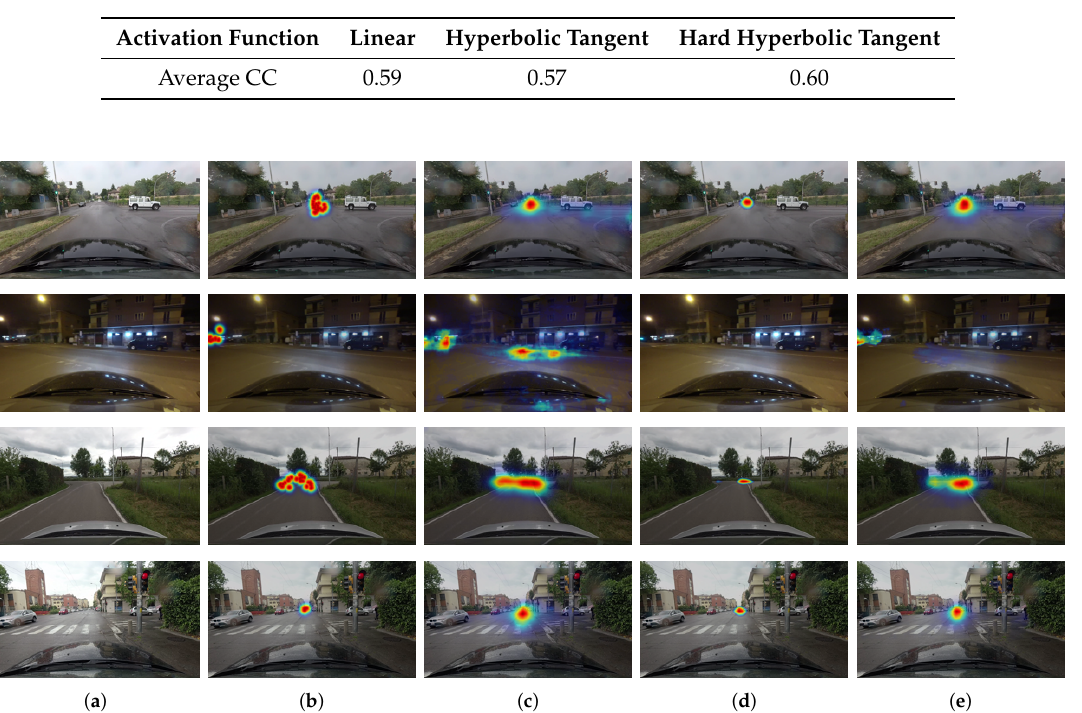
Table 2. Analysis of attention performance with different activation functions.